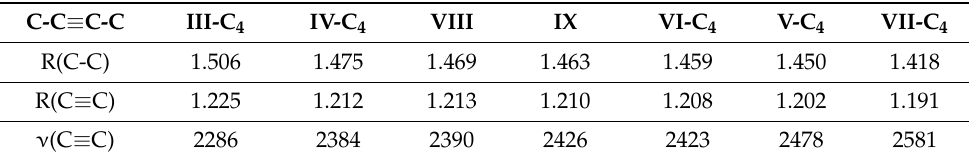
Figure 2. Structures with extremely short B ≡ B (VII-B 2 ) and C ≡ C (VII-C 4 ) triple bonds. Table 4. Bond distances (C-C and C ≡ C in Å) for the central linear C-C ≡ C-C unit of propellanes III-C 4 ÷ VII-C 4 and two di-substituted acetylenes R- C ≡ C-R (R=2-Adamantyl (VIII) and R=Methyl (IX)). Frequency of Raman-active C ≡ C stretch (in cm − 1